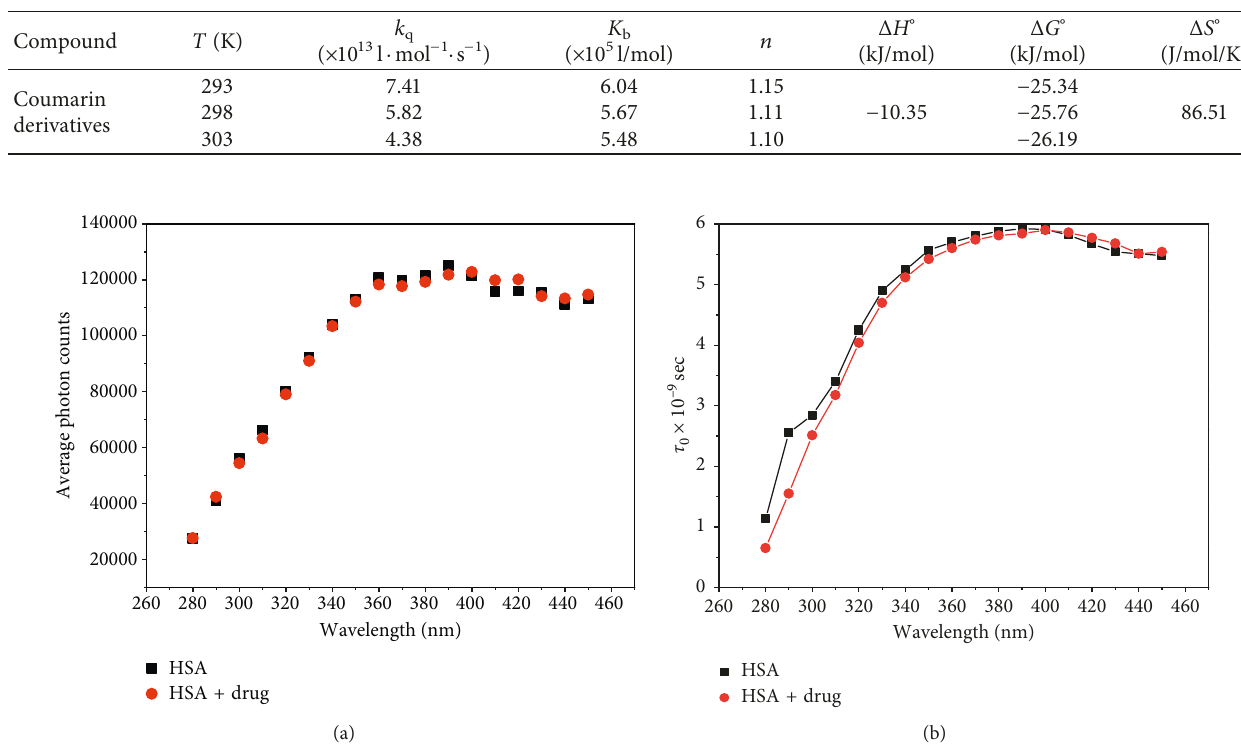
Table 1: Fluorescence binding parameters for HSA-coumarin derivatives (pH 7.4).